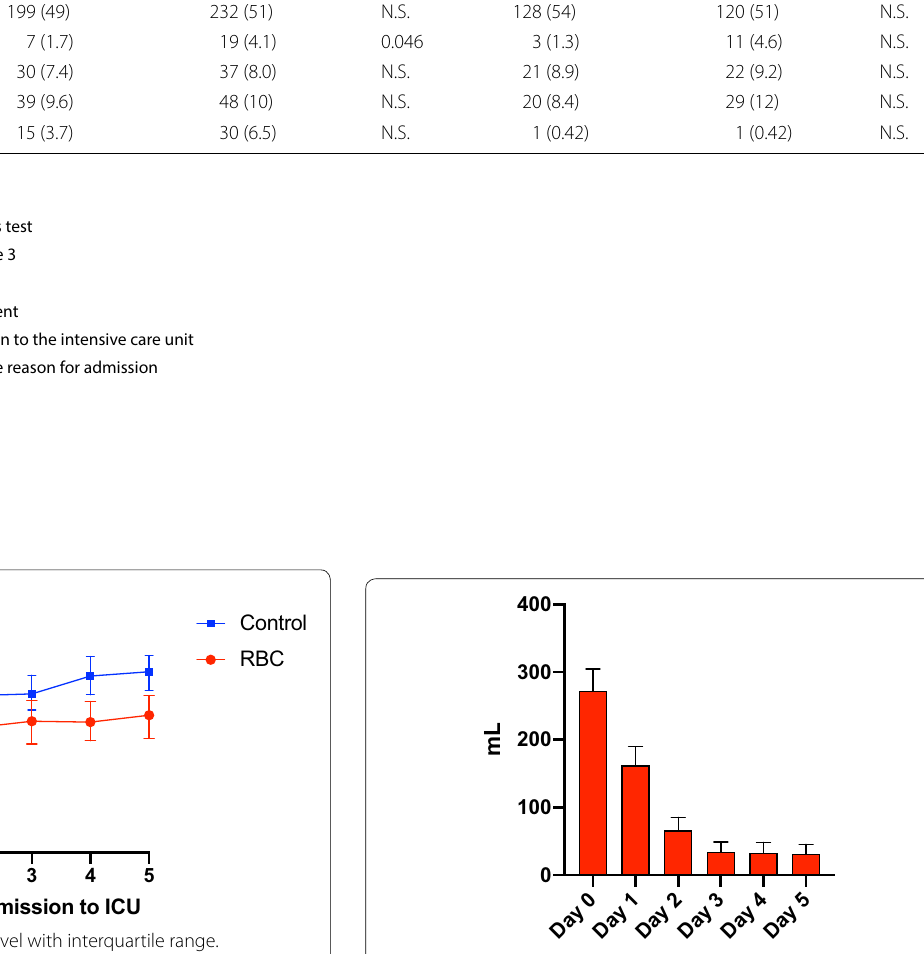
Fig. 3 Mean red blood cell transfusion per day with 95% confidence interval in the RBC group.